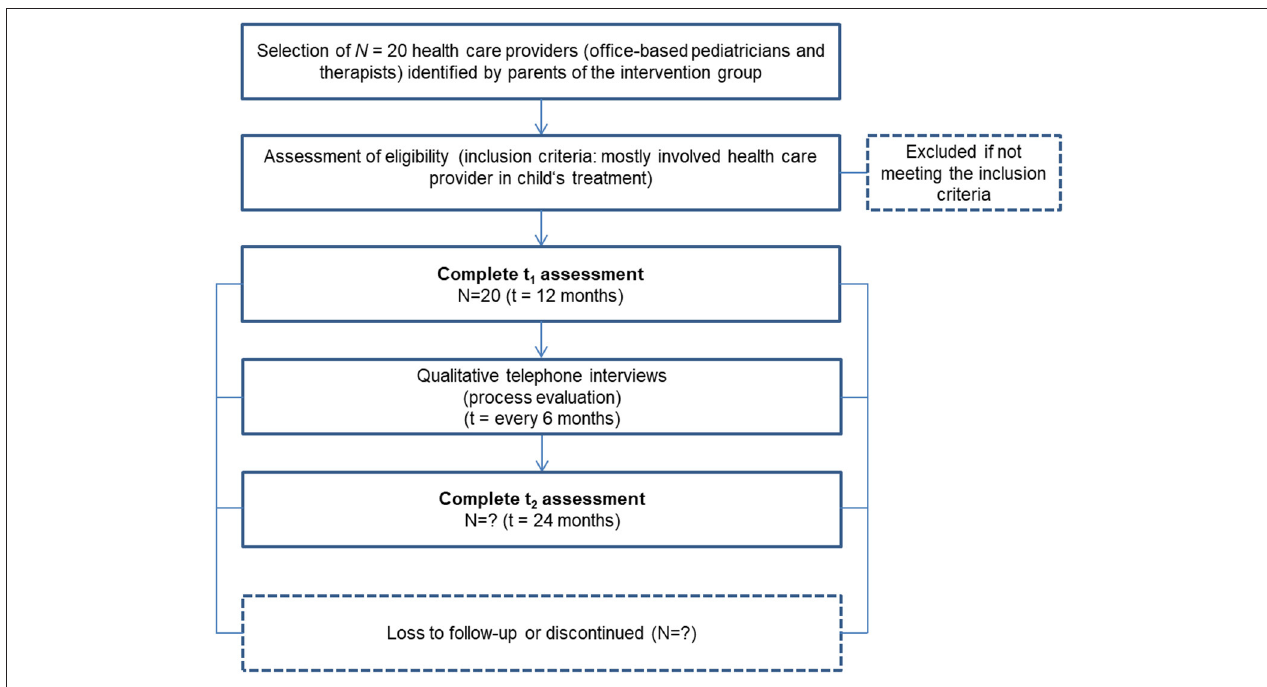
FIGURE 3 | Participant timeline of healthcare providers in phase